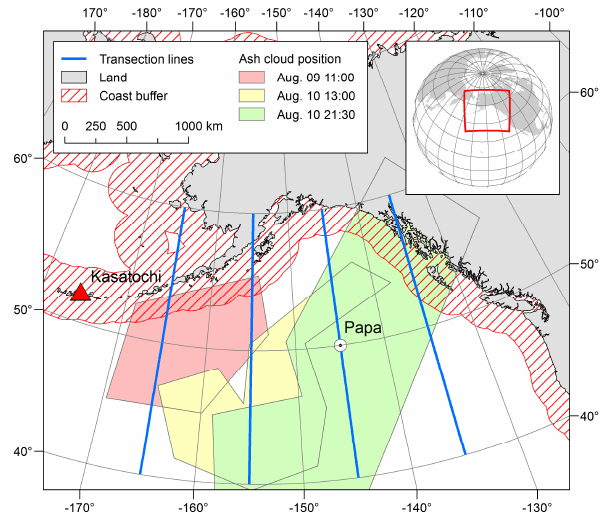
Fig. 6. To eliminate the signal from nutrient supply in coastal areas, a 200 km buffer along the coast (striped red) is removed from the analysis. The blue lines mark the positions of the N–S transects for the analysis of the MODIS Aqua 8-day composites of Chl- a . The coloured polygons illustrate the dimension and the changing position of the volcanic ash plume as provided by VAAC.